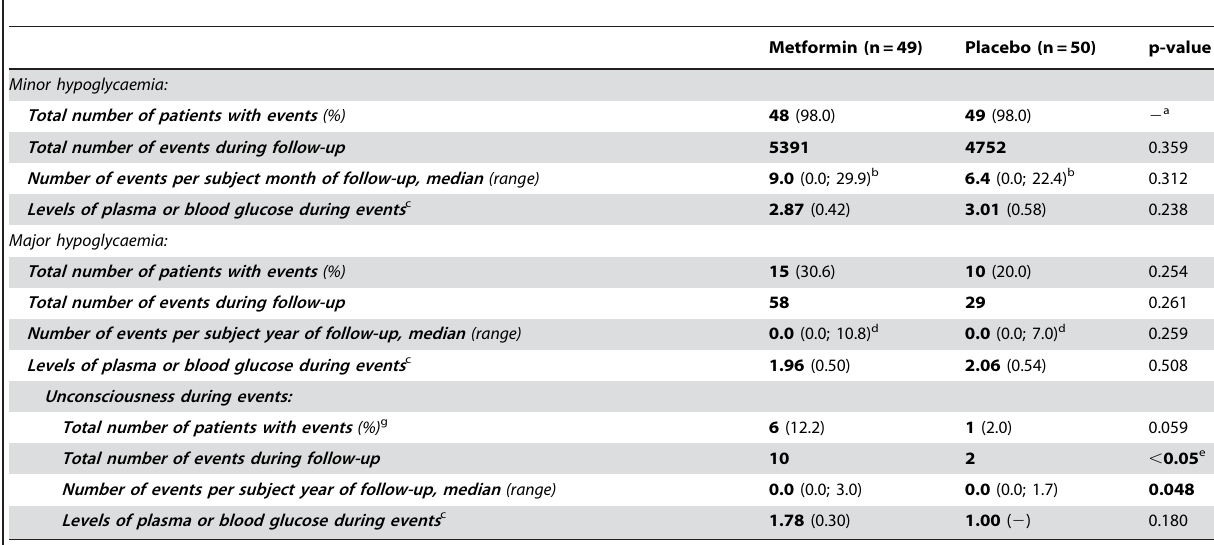
Table 4. Reported hypoglycaemic episodes in patients with type-1 diabetes during one year of treatment with metformin or